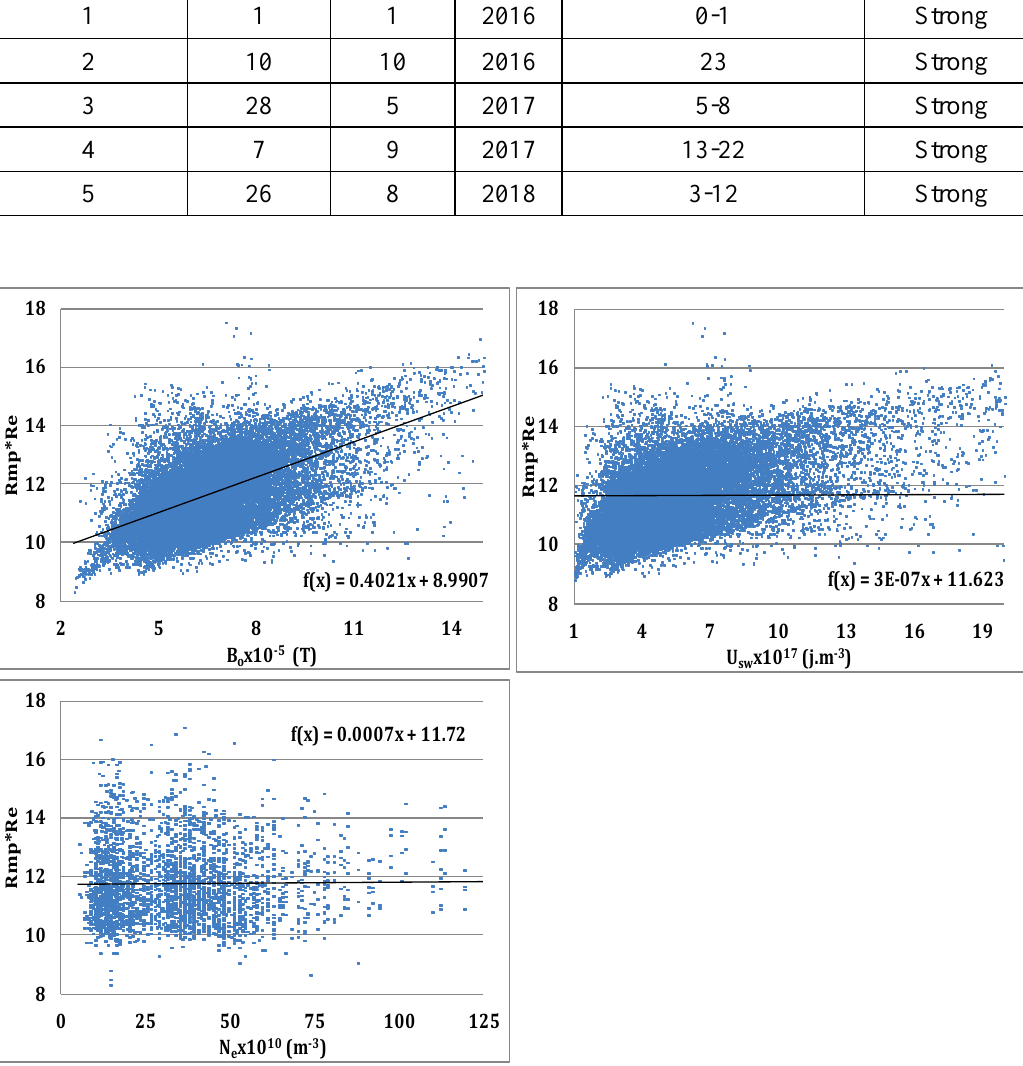
) with (B ), (U ) and (N ) for years 2016- 2018. mp o sw e